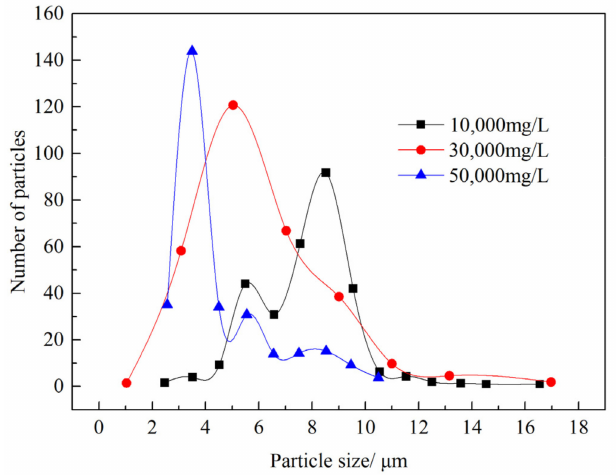
Figure 12. Relationship between the emulsion size distribution and salinity.